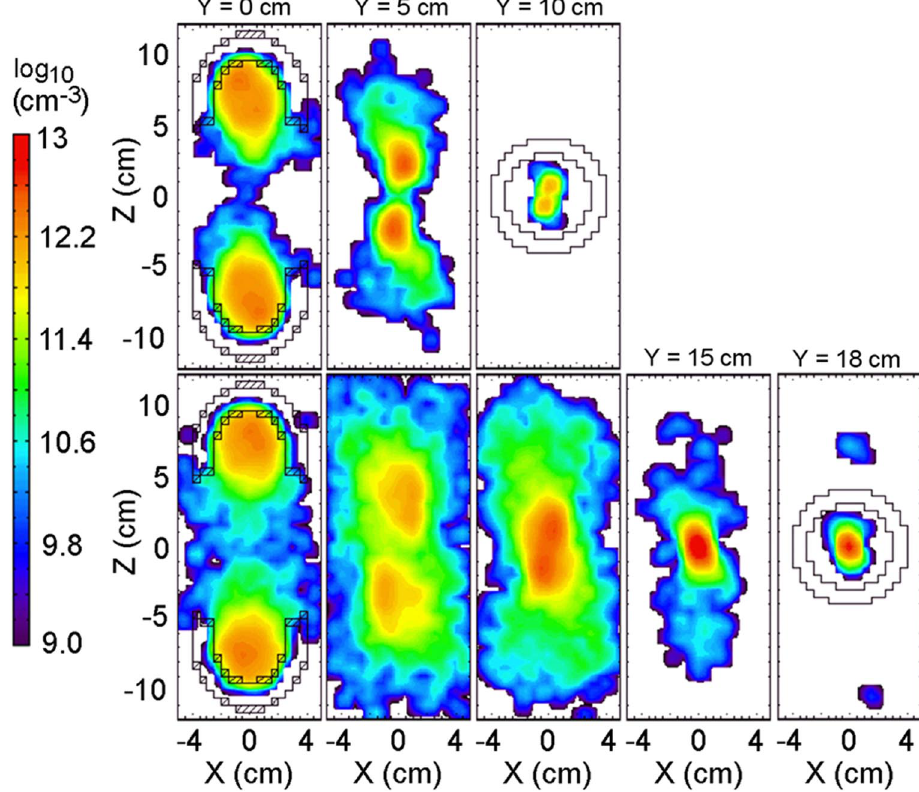
FIG. 17. (Color) f x; z g isocontours of n (cid:6) 53 kG final-focus solenoid, with a separation distance d (cid:6) 8 cm (top) and d (cid:6) 16 cm B z